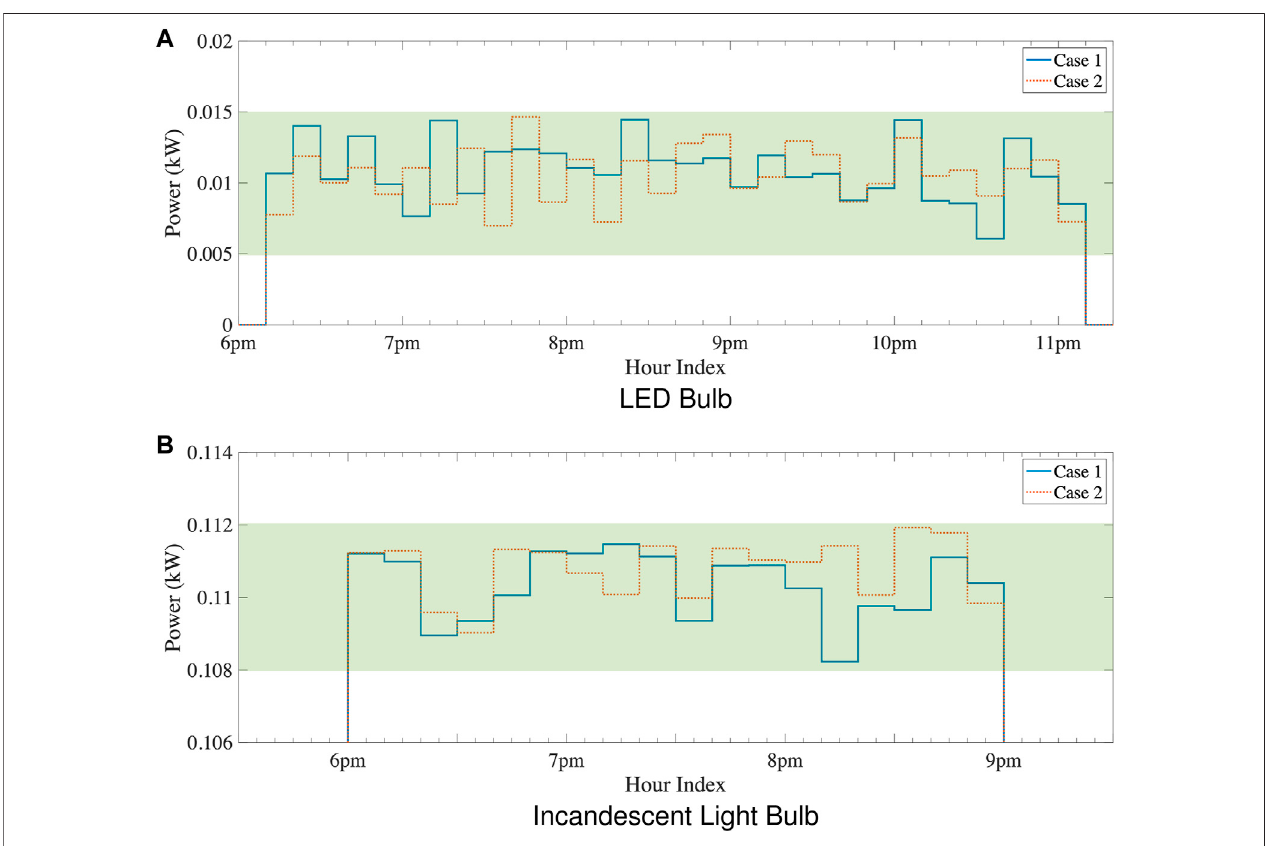
FIGURE 14 | Power consumptions of the PAAs under two cases.